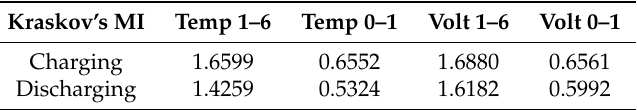
Table 3. The MI coefficients from multivariate estimation gathered from reduced thermal and voltage vectors during charging and discharging period.